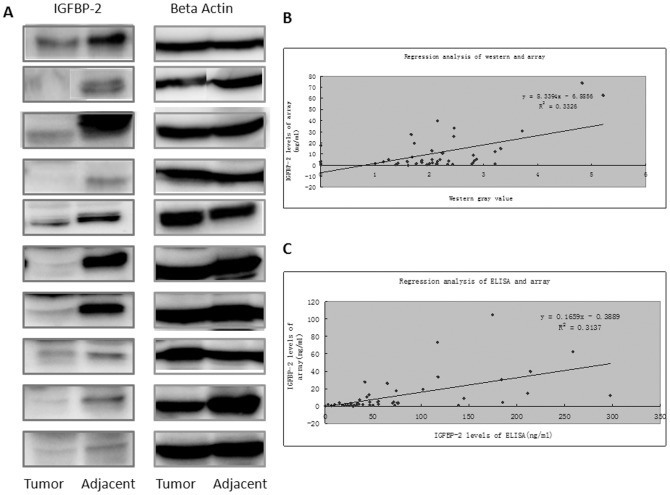
The confirmation of IGFBP-2 expression by Western blotting and ELISA.The expression of IGFBP-2 was further determined by Western blotting analysis and the representative data were shown in (A). The correlation between antibody arrays and Western blotting was determined using regression analysis .and shown in (B). Similarly, the correction between antibody arrays and ELISA was shown in (C).